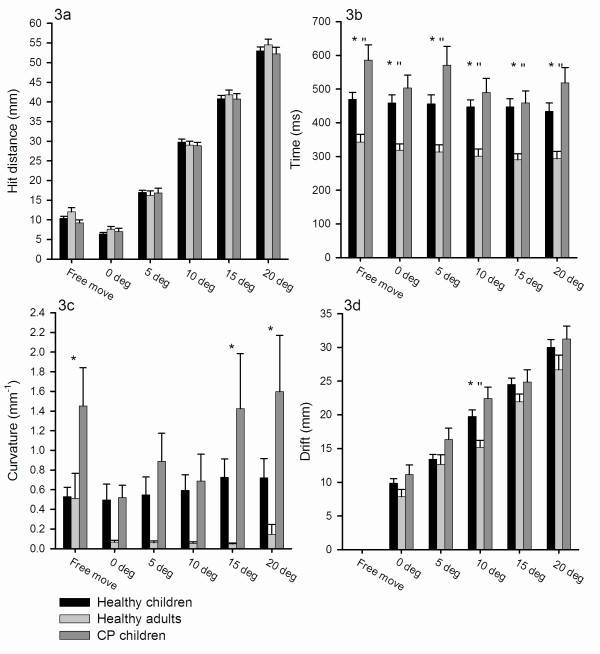
Motor performance comparison for the three experimental groups. Figure 3a displays the average distance (mm) for the hit-distance for the three groups in the different categories of movement manipulations. There is no statistical difference between the three groups (p = 0.389). 3b depicts the averaged time (ms) it takes for the three groups to complete the different movement manipulations. The * represents a significant (p < 0.03) difference between the CP children and one or both of the healthy groups and the "represents the significant difference between the healthy children and the healthy adults. 3c illustrates the curvature (mm-1) for the three groups during the different movement manipulations. The * and "represent significant difference between the CP children and the two healthy groups and the healthy children and the healthy adults (p < 0.003). The greater the curvature is, the more the deviations from a straight line occur for the visual moving object to reach the target. 3d shows the average drift (mm) for the three groups during the individual movement manipulations. The drift is a measure of how much the subjects are deviating or compensating for the computer manipulation of the visual objects in the reverse direction. As there is no computer manipulation at Free Move, the Drift is zero. The greater the score, the more the subjects have tried to compensate for the deviation of the visual object. The * represents a significant difference between the CP children and the both of the healthy groups, and the "indicates a significant difference the healthy adults and the healthy children (p < 0.05).